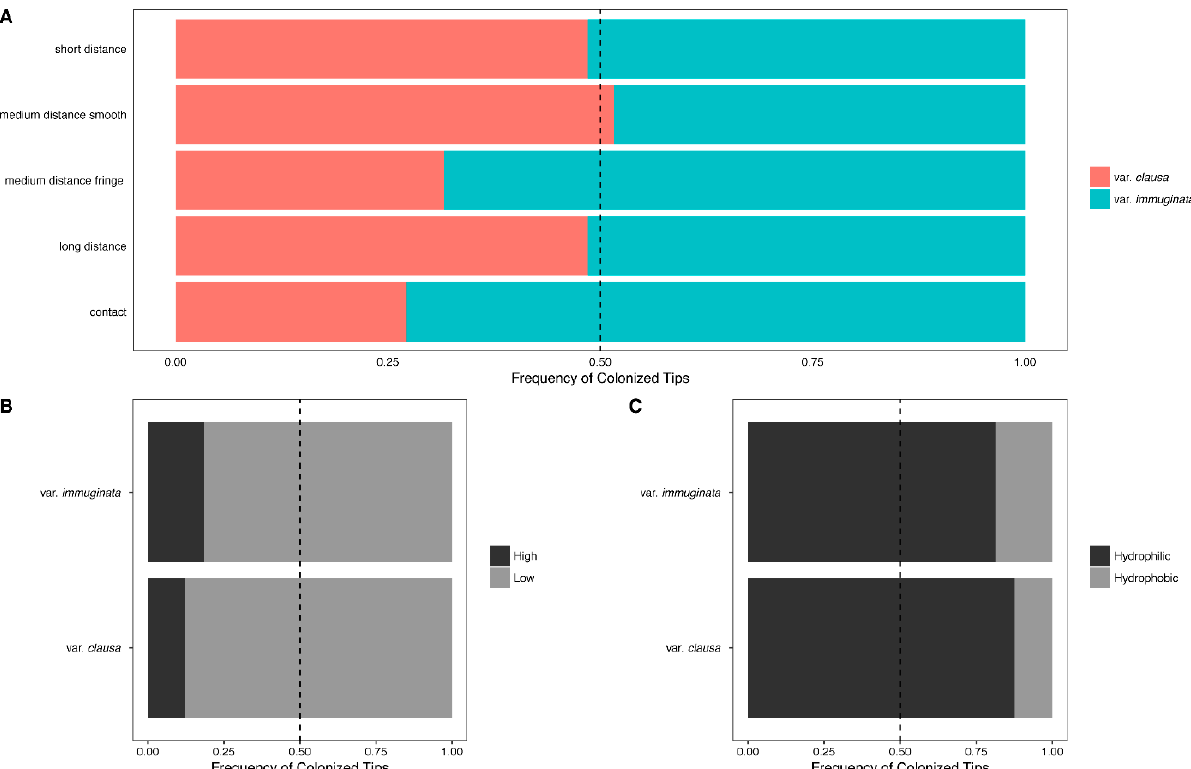
Figure 3. Nonmetric multidimensional scaling ordinations for fungal communities as a function of host variety. Points repre ‐ sent communities recovered from individual trees of Pinus clausa var. clausa (salmon) and Pinus clausa var. immuginata (blue). Ellipses indicate 95% confidence intervals, while arrows specify significant indicator species associated with each variety.